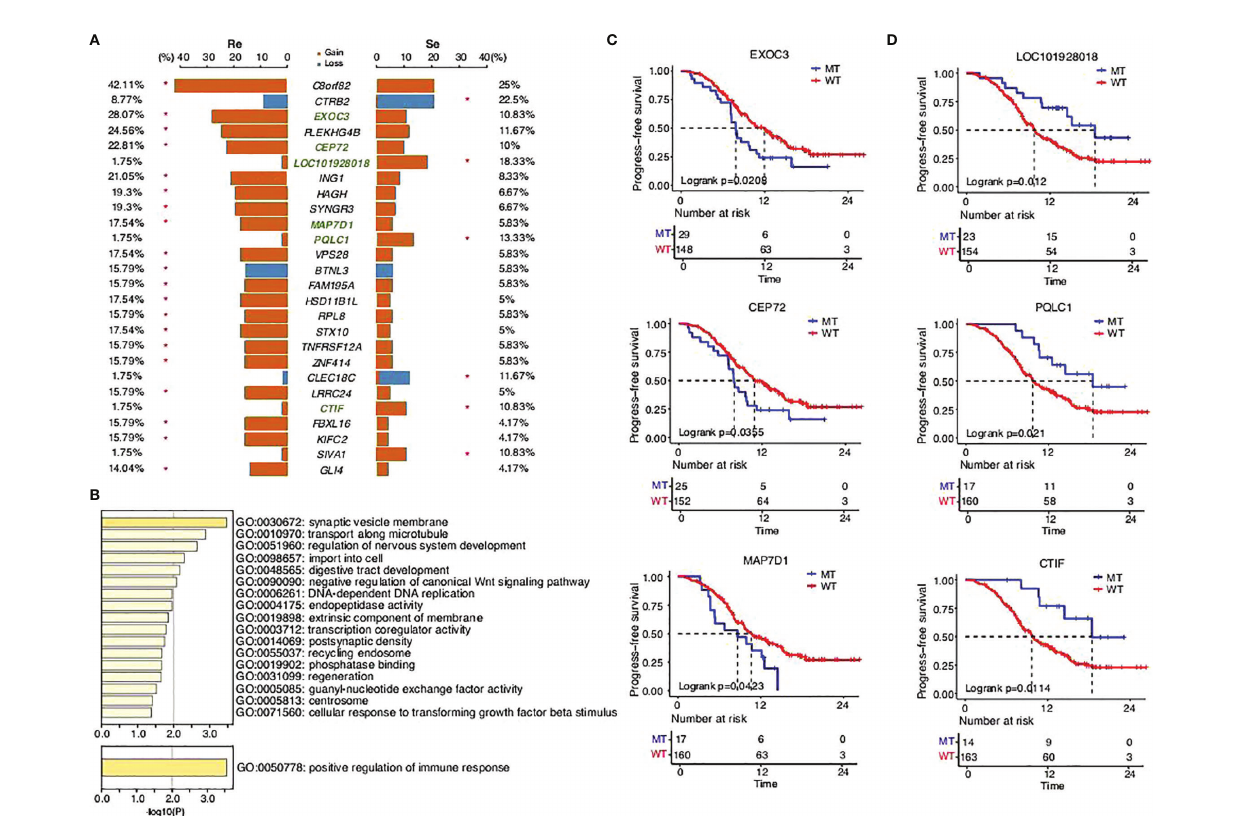
FIGURE 3 | SCLC patients ’ copy number variant in the two groups. (A) Comparison of the copy number variants with a mutation frequency greater than 5%. (B) GO functions enriched by all the mutations predicted in this study. KEGG pathways enriched by the mutations that signi fi cantly affected PFS time in this study. (C,D) Progression-free survival status of the different